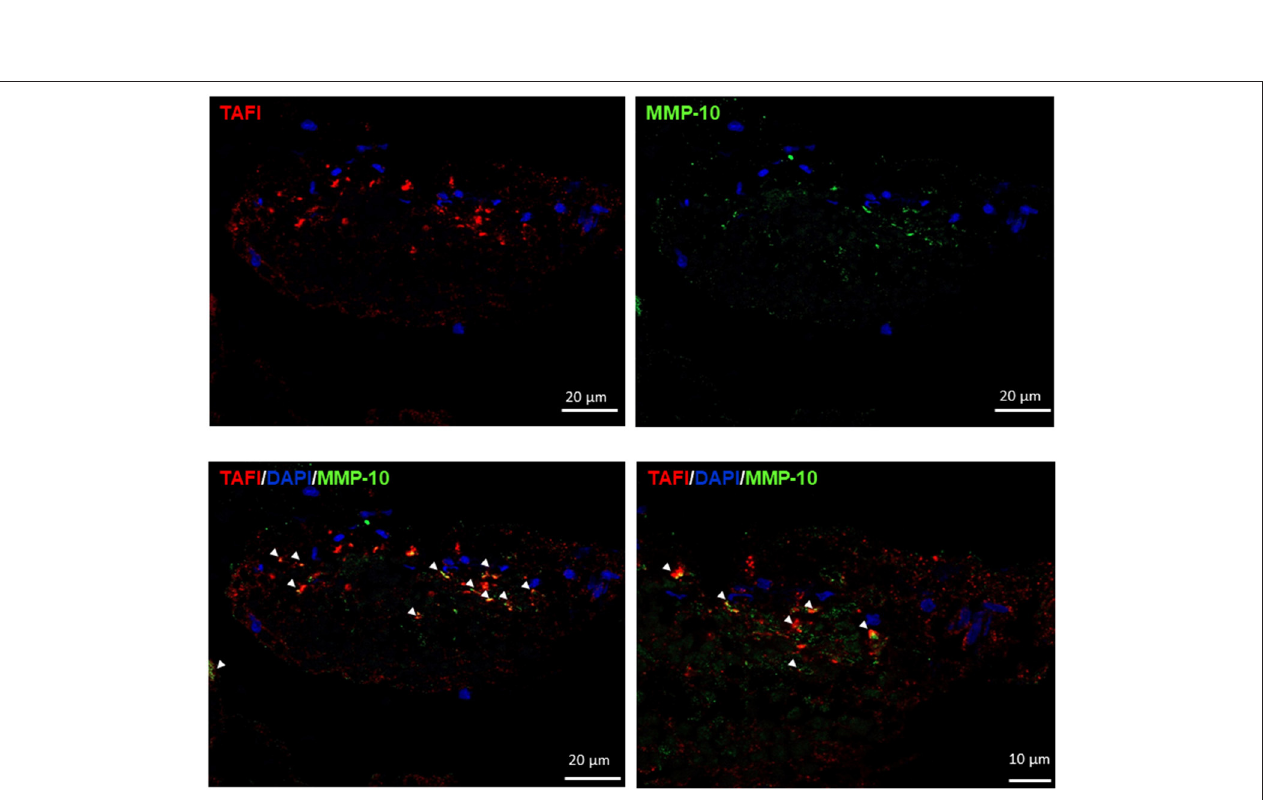
FIGURE 4 | Matrix metalloproteinase-10 (MMP-10) and thrombin-activatable fibrinolysis inhibitor (TAFI) colocalization in thrombi. Immunofluorescence for TAFI (red), MMP-10 (green), and 4 ′ ,6-diamidino-2-phenylindole (DAPI) (blue). Arrow heads point to double positive cells for MMP-10 and TAFI. Scale = 20 and 10 µ m.